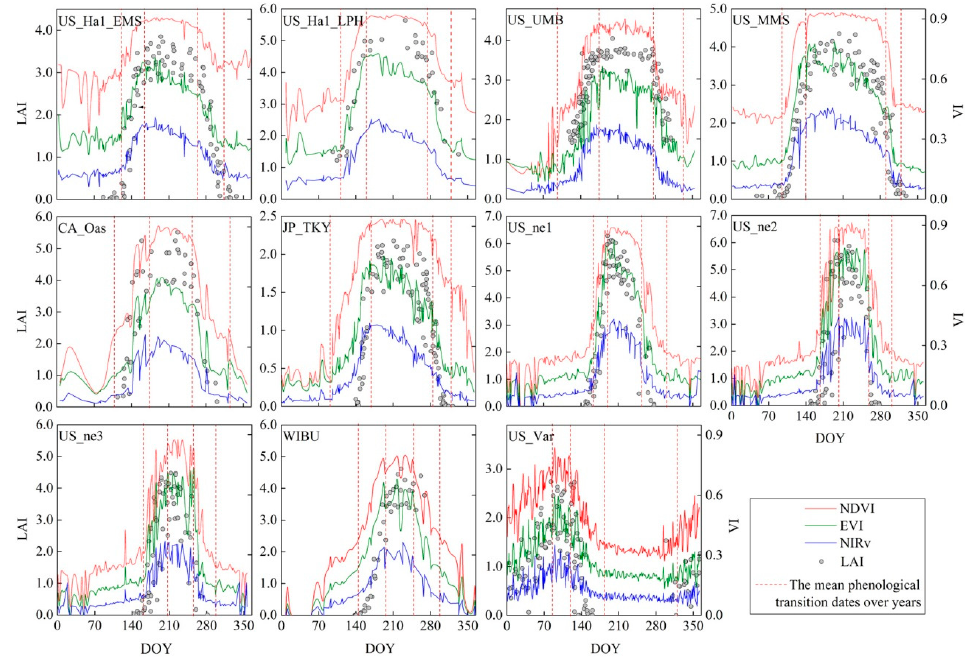
Figure 1. The leaf area index (LAI) and vegetation index (VI) profiles marked with four mean phenological transition dates over the years. The red vertical dashed lines from the left to right are green-up, maturity, senescence and dormancy (for the US_Var site, the red vertical dashed lines represent maturity, senescence, dormancy and green-up from the left to right,). Table 2. The four phenological transition dates of vegetation at each site (mean day of year (DOY) ± standard deviation).